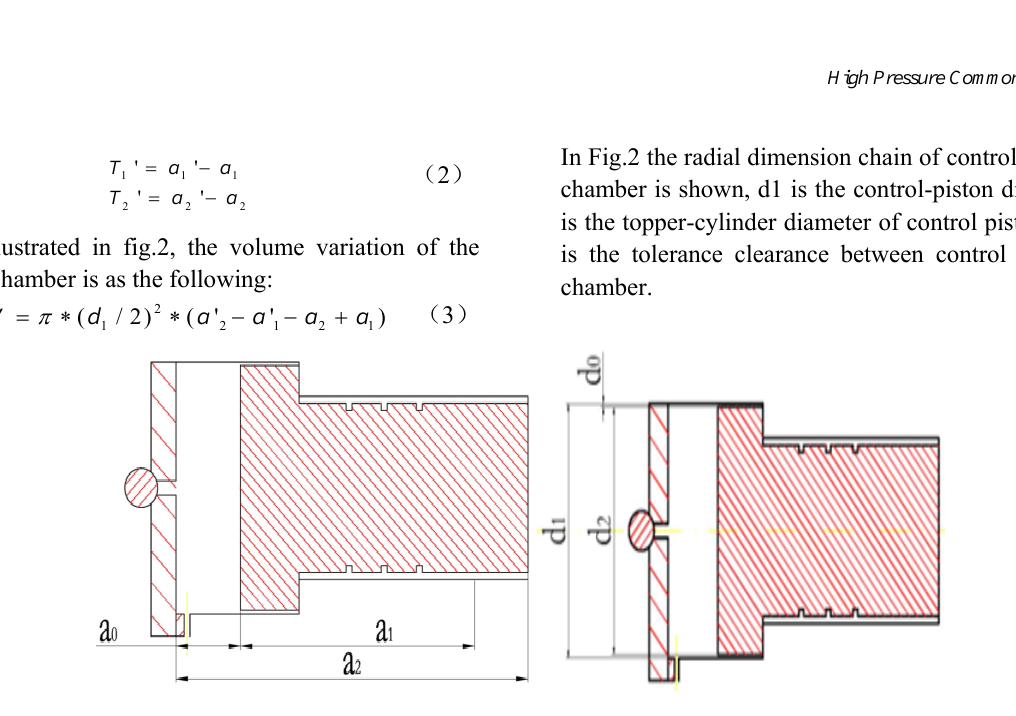
Fig.2 Assembly dimension chain of injector control